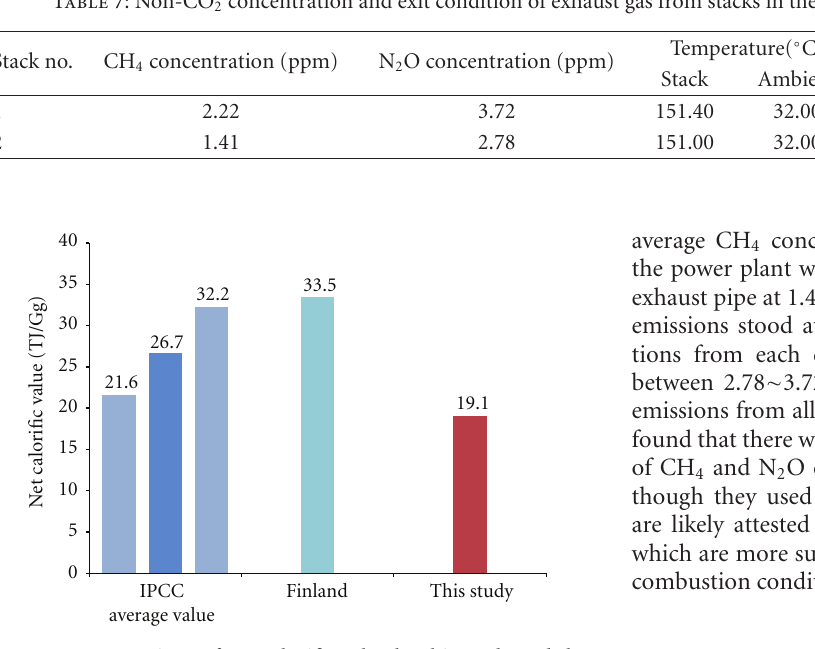
Figure 4: Comparison of net calorific value by this study and the